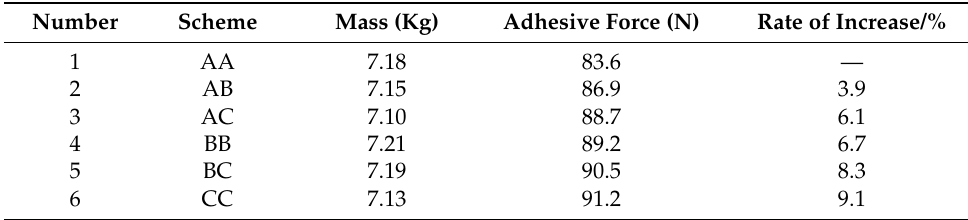
Table 7. Adhesive force comparison of different track shoes.